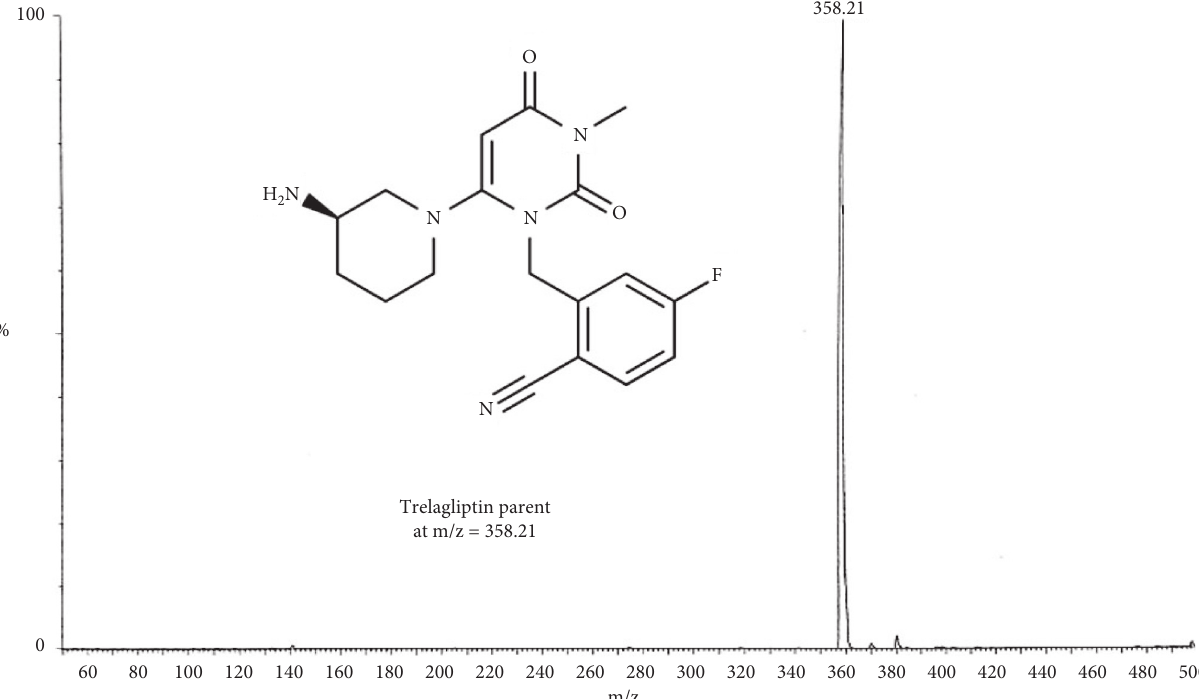
Figure 1: MS of TLN and its chemical